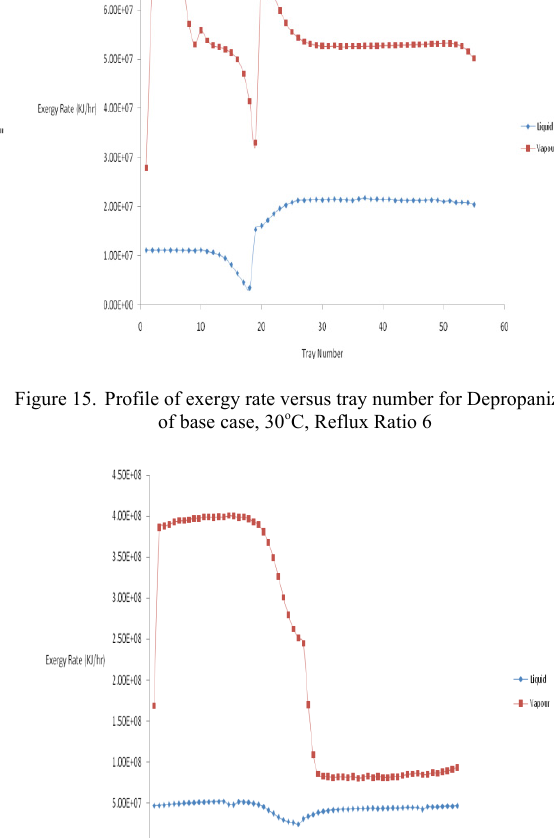
Figure 13. Profile of exergy rate versus tray number for Depropanizer of base case, 30 o C, Reflux Ratio 2